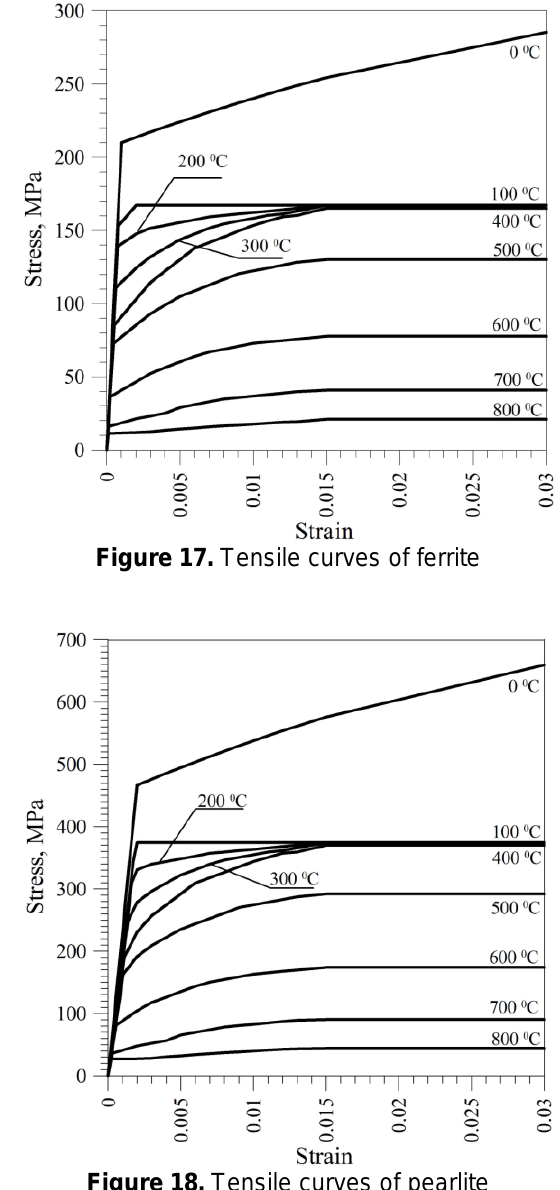
Table 1. Structural (  ) and thermal (  ) expansion